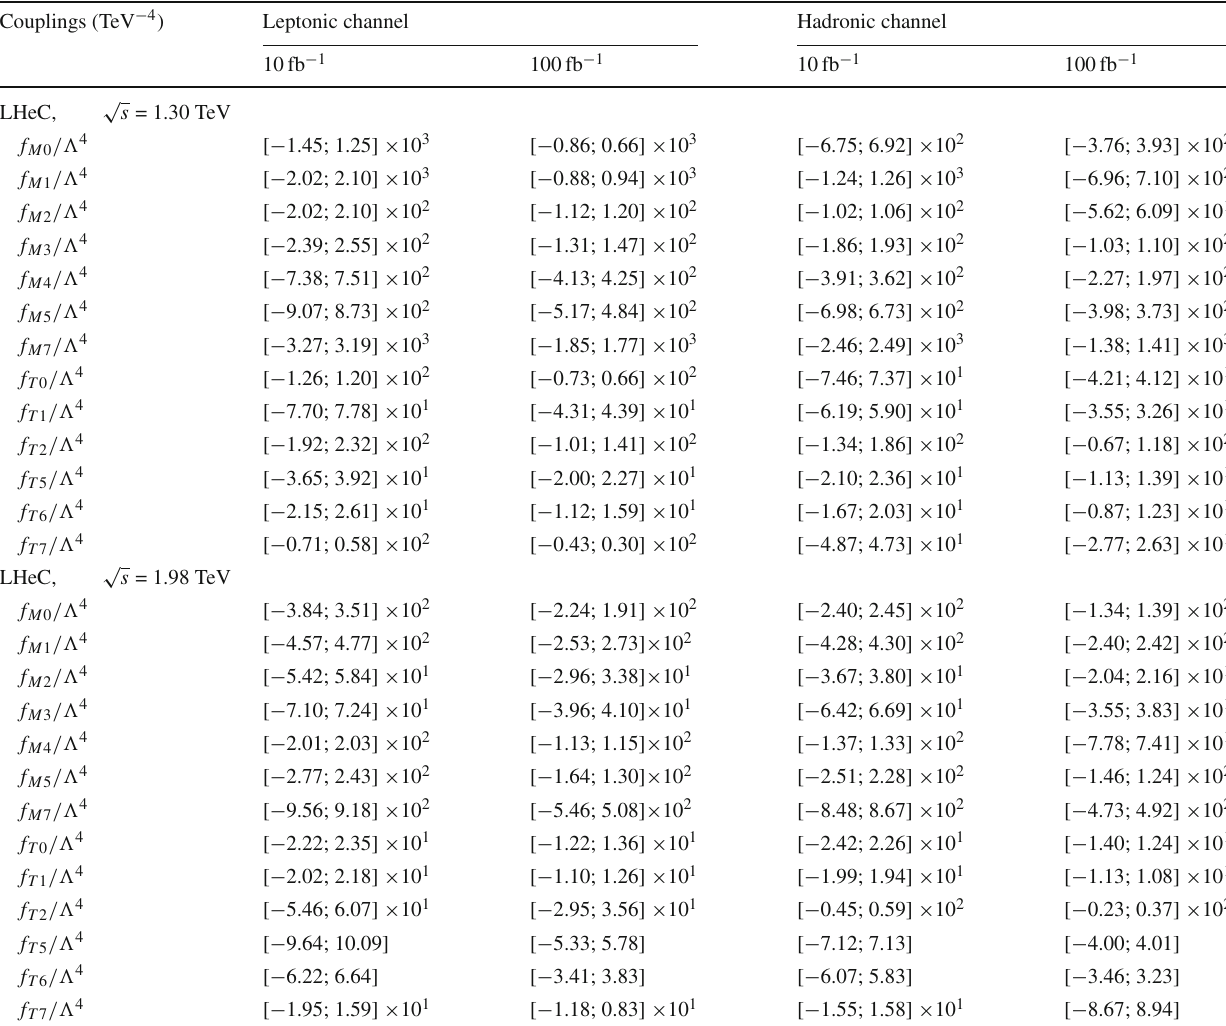
Table 6 Sensitivity measures on the aQGC at the 95% C. L. via the process e − p → e − γ ∗ p → pW − γν e at the LHeC with Here, we consider that only one of the anomalous couplings deviates from the SM at any given time Couplings (TeV − 4